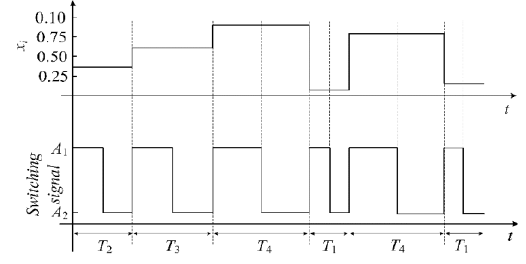
Figure 10. Principle of discretely chaotic modulation.